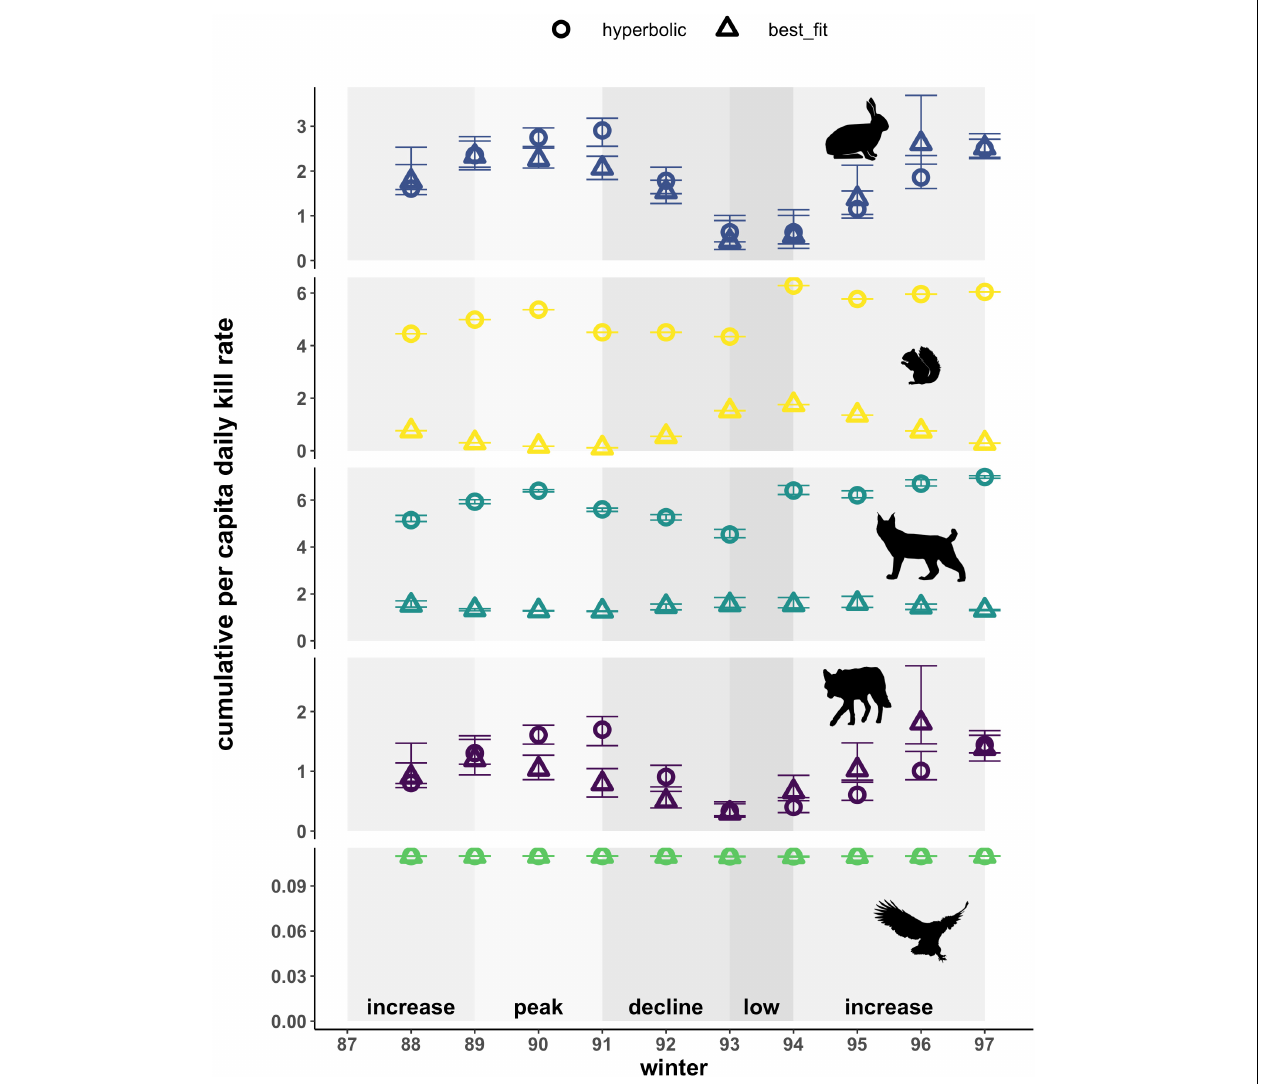
FIGURE 4 | Cumulative per capita daily kill rates for prey (hare, red squirrel) and predators (lynx, coyote, owl) based on hyperbolic and best-fit functional response models. Cumulative per capita daily kill rates represent the number of individuals killed summed across all types of predators for each prey, and the number of individuals killed summed across all prey types for each predator. Error bars show uncertainty in cumulative per capita kill rates based on upper and lower limits of 95% confidence intervals for hare density estimates. Shading indicates phases of the cycle as defined by hare density. Also note varying y-axis scale for each